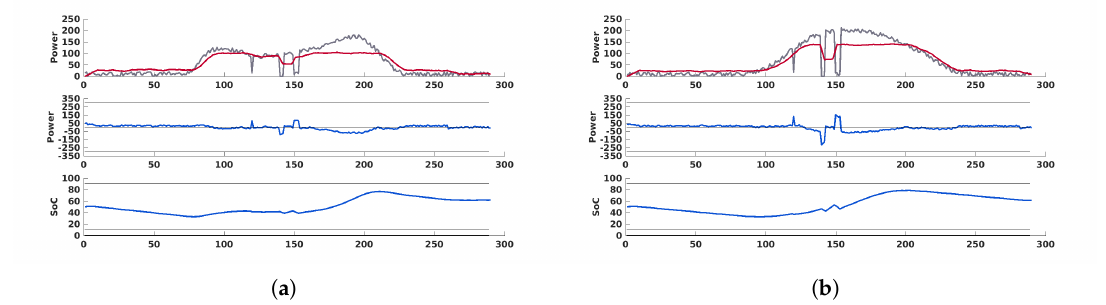
Figure 14. Top: Grid power flow with FBM-MA ( P g , red) and without FBM-MA ( P hcpv , grey). Middle: Battery power evolution ( P ess , blue) and constraints (grey). Bottom: Battery SoC evolution (blue) and constraints (grey). On a cloudy day case ( a ), on a sunny day ( b ).